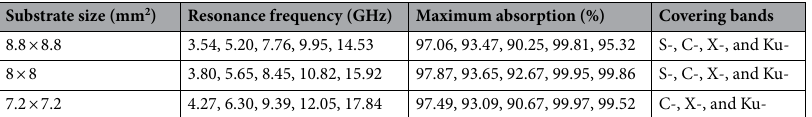
Table 7. Effect of substrate size on absorption peaks, resonance frequencies, and covering bands.